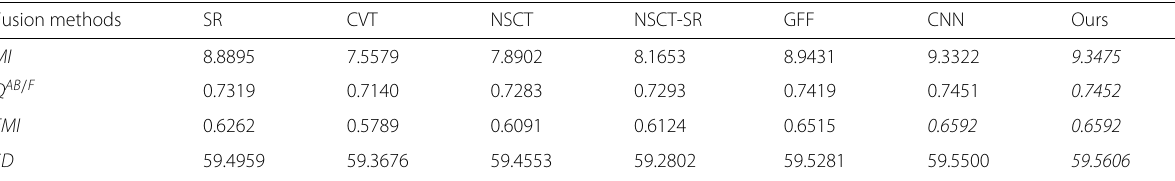
Table 3 Objective contrast of “Profile” Fusion